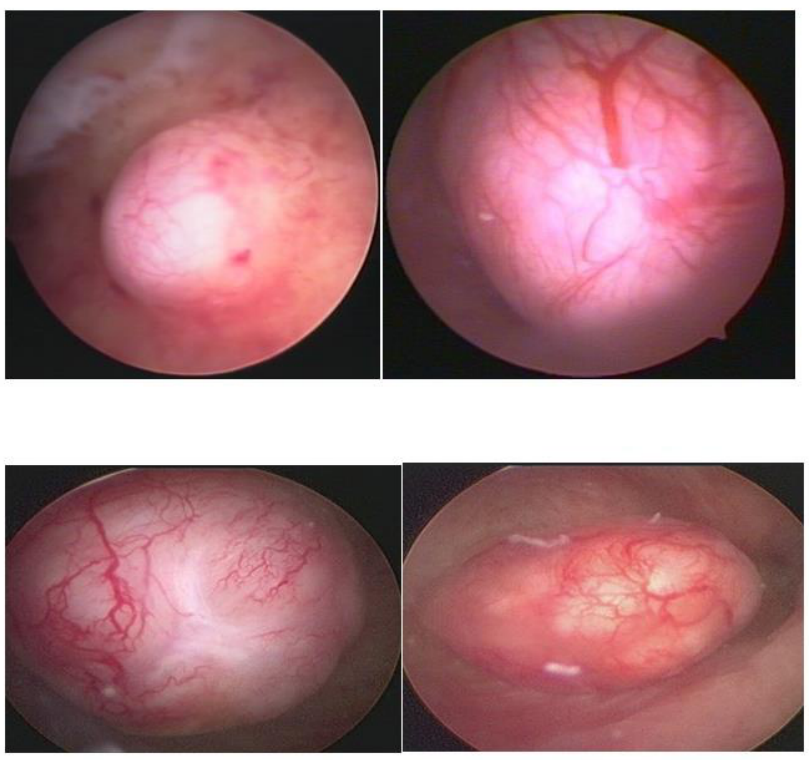
Figure 1. Submucous myoma — hysteroscopic view.